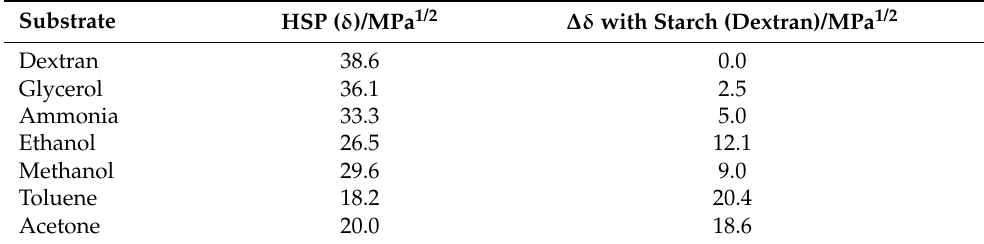
Table 5. The HSP ( δ ) values of the polymer matrix and volatile solvents [55,69].